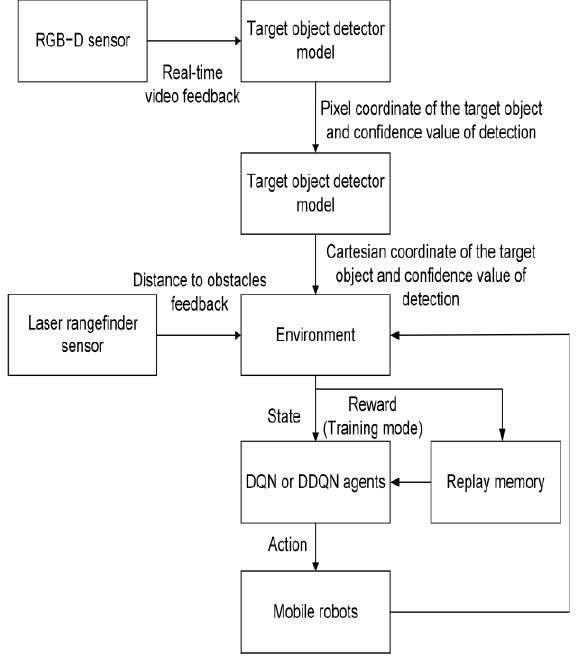
Figure 2. Proposed block diagram of mobile robot navigation using a DQN/DDQN agent. Algorithm 1 DQL Training